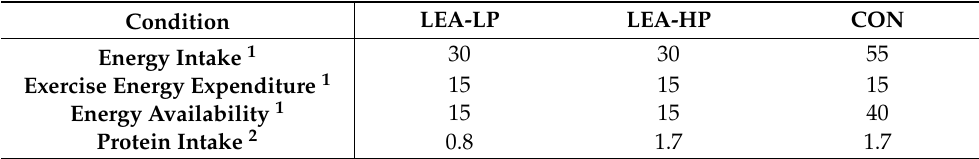
Table 1. Energy and protein characteristics of the three conditions. Condition LEA-LP LEA-HP CON Energy Intake 1 30 30 Exercise Energy Expenditure